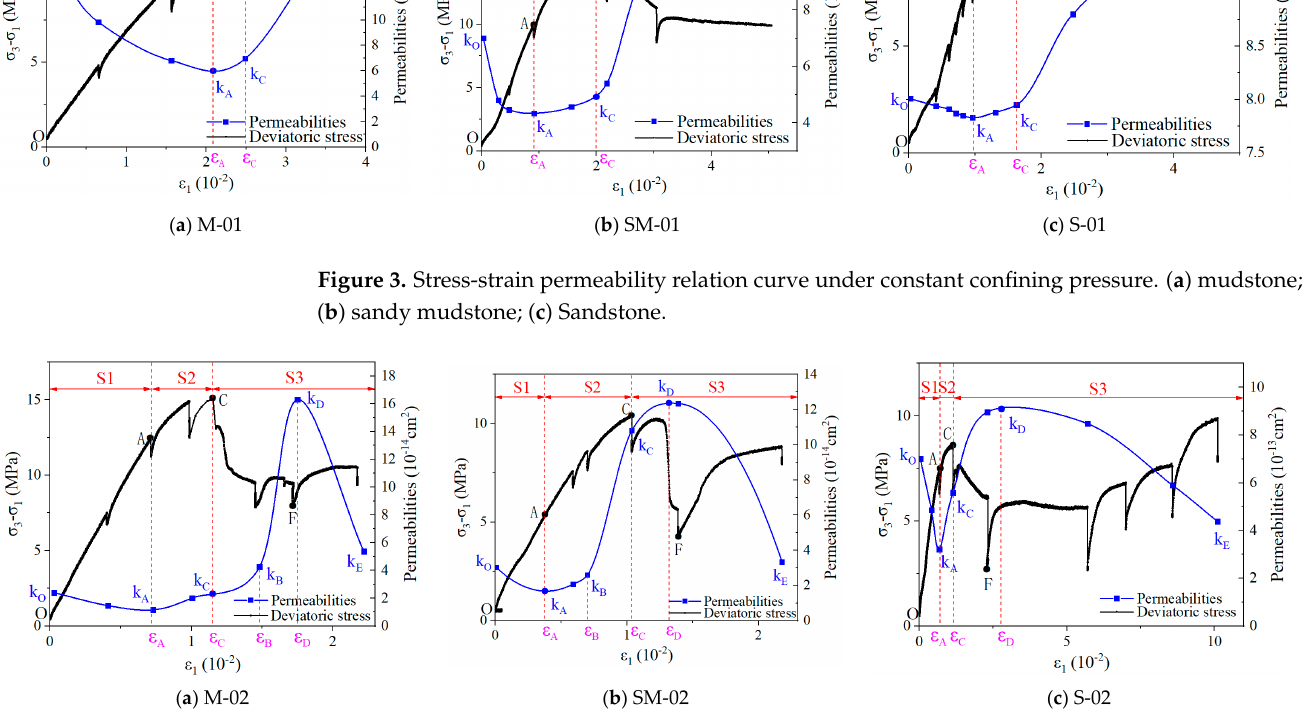
Figure 4. Stress-strain curve and permeability curve of rock samples under mining-induced stress path. ( a ) mudstone; ( b ) sandy mudstone; ( c ) Sandstone.